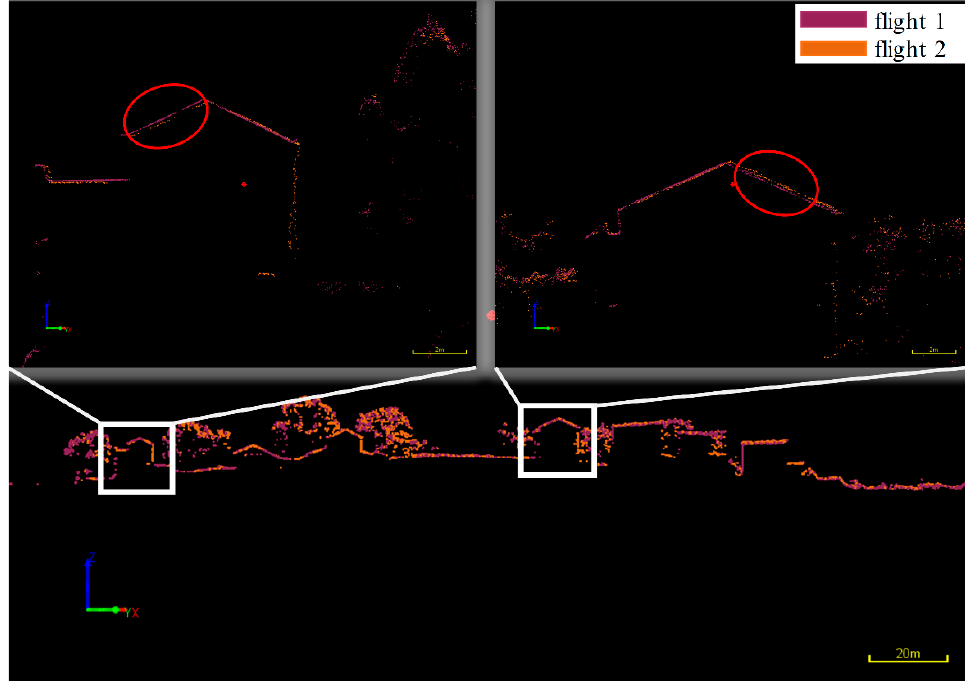
Figure 19. Parallel section of point cloud in in opposing flight strips (flight 1 and flight 2). ( a ) With- out installation angle compensation; ( b ) With installation angle compensation.